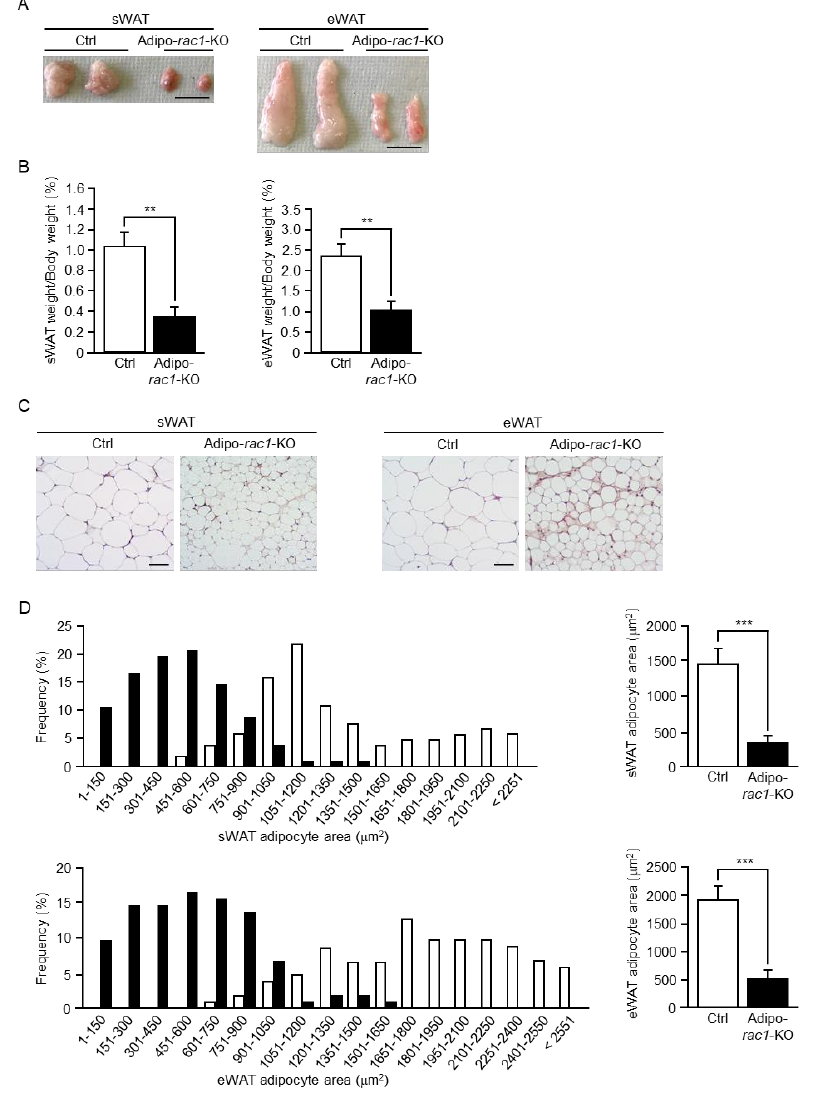
Figure 2. Atrophy of WAT in adipo- rac1 -KO mice. ( A ) Representative images of sWAT and eWAT excised from 26-week-old control and adipo- rac1 -KO mice. Scale bar, 1 cm. ( B ) Wet weight (relative to body weight) of sWAT and eWAT excised from 26-week-old control and adipo- rac1 -KO mice. Data are shown as means ± S.E. ( n = 10). ** P < 0.01. ( C ) Hematoxylin-eosin staining of sWAT and eWAT sections prepared from 26-week-old control and adipo- rac1 -KO mice. Scale bar, 50 μm. ( D ) Adipocyte areas of sWAT and eWAT excised from 26-week-old control and adipo- rac1 -KO mice. Histograms depict the distribution of areas of control (white bars) and rac1 -KO (black bars) white adipocytes. Data are shown as means ± S.E. ( n = 100). *** P < 0.001.